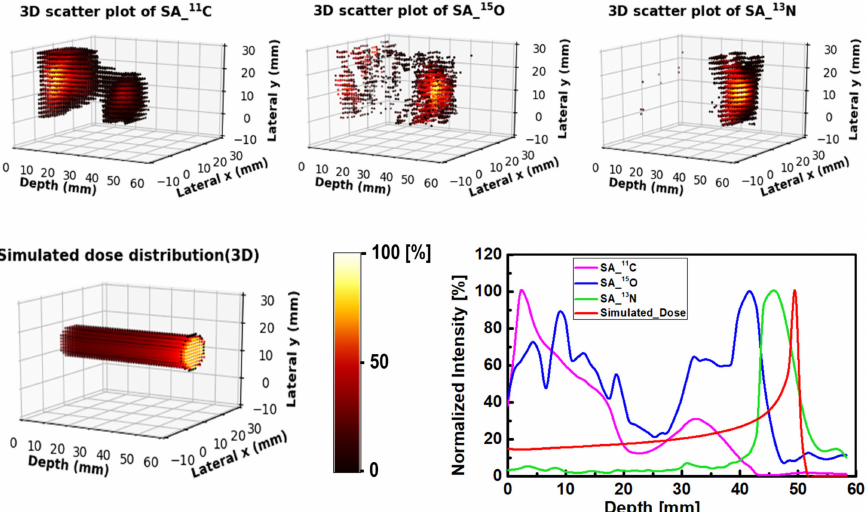
Figure 8. Three-dimensional scatter visualization and the 1D profiles of 11 C, 15 O and 13 N radioiso- topes, along with the simulated dose for the 80 MeV proton beam irradiating water-gel